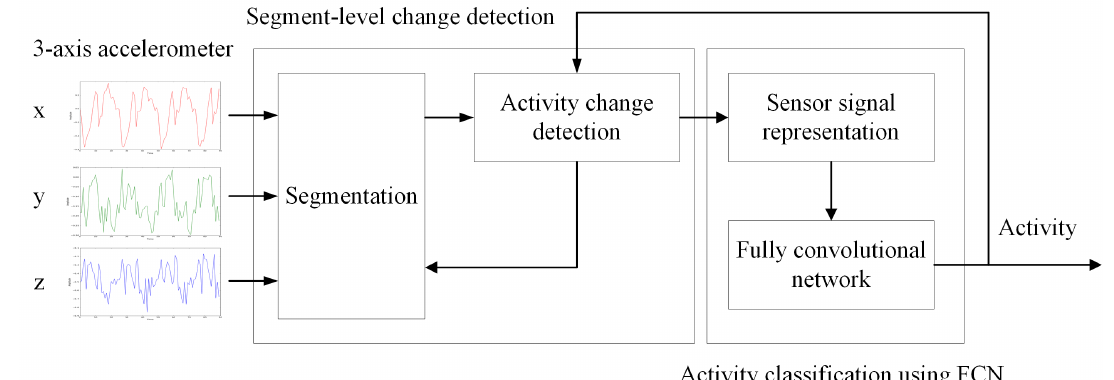
Figure 1. Proposed energy-efficient human activity recognition